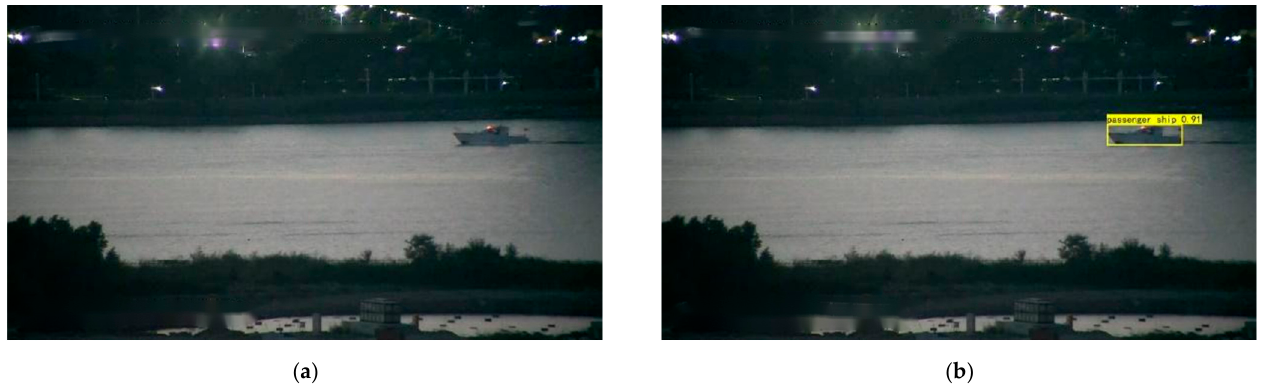
Figure 11. Comparison of small target detection effect under dark light conditions. ( a ) YOLOX_s detection results; ( b ) CBAM-YOLOX detection results.